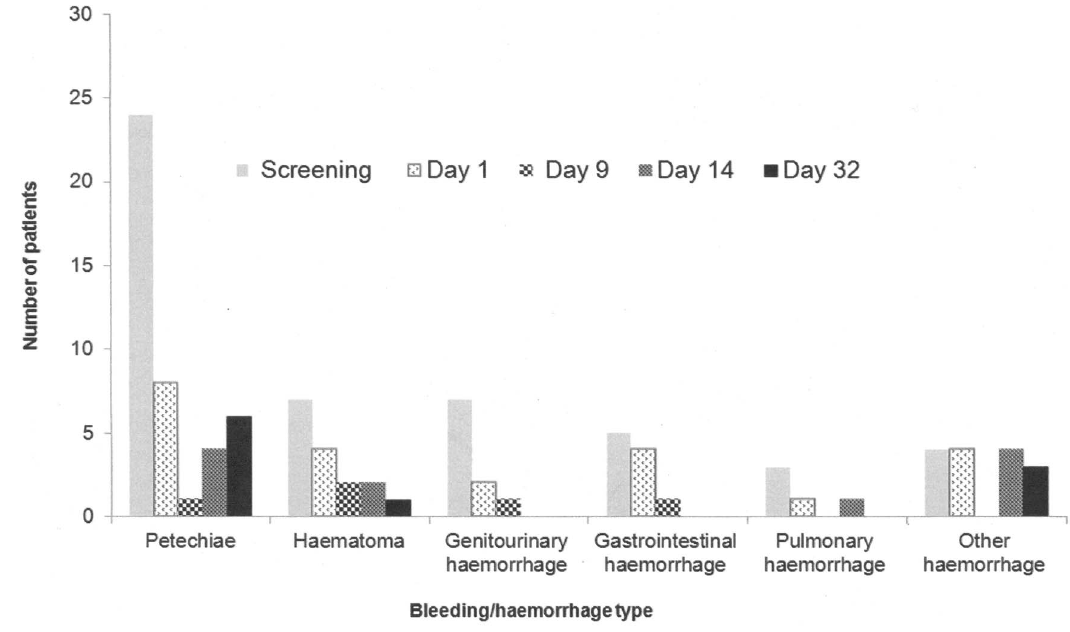
Figure 3. Bleeding/haemorrhage reports from screening to Day 32.